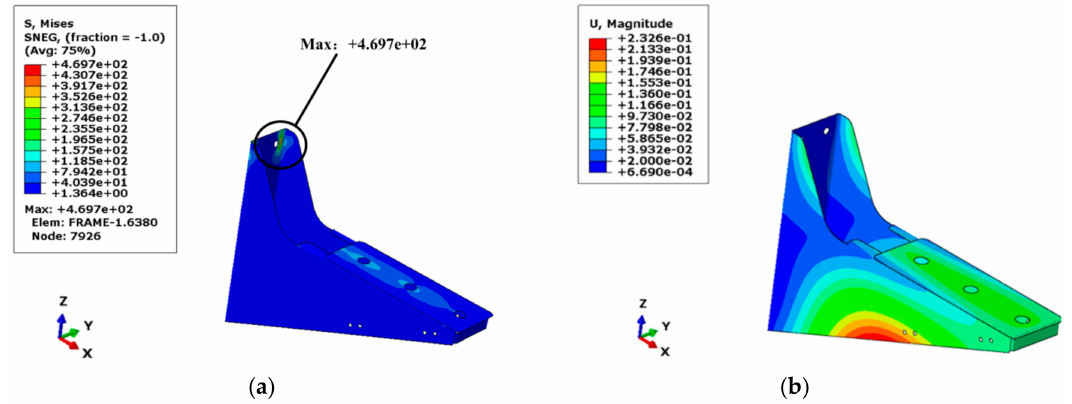
Figure 2. Von Mises stress nephogram ( a ) and ( b ) displacement nephogram of the initial designed seat